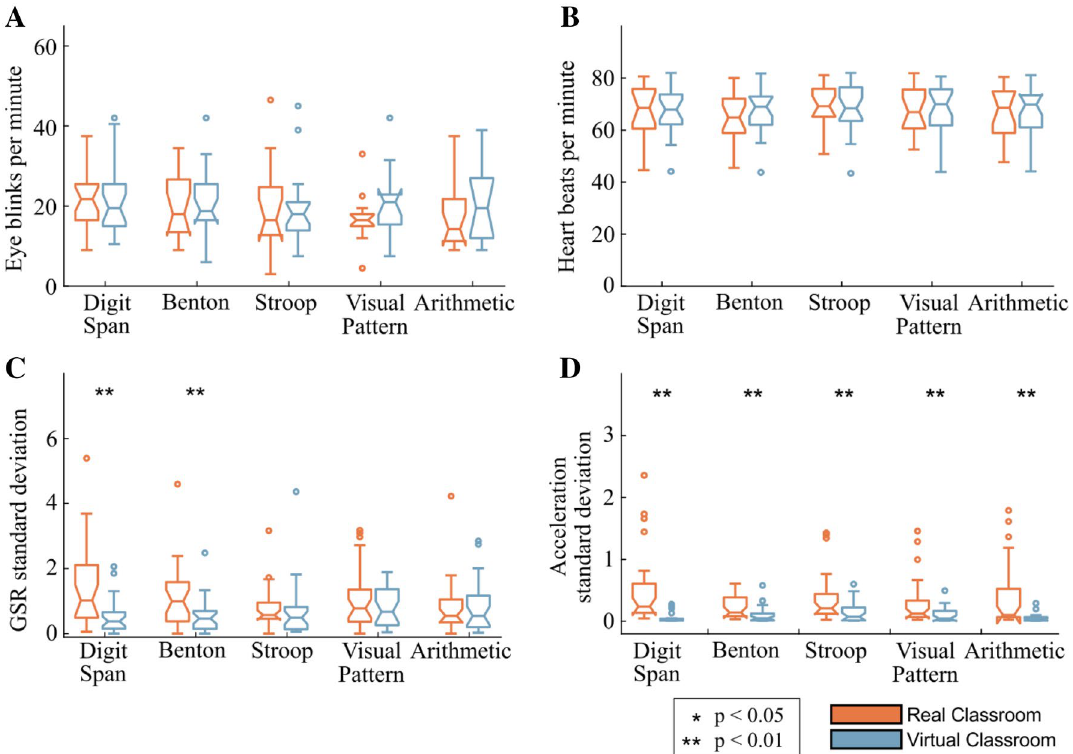
Figure 3. Physiological responses in the real-world classroom environment vs. identical virtual classroom. The color bars indicate the median scores in each environment, with the first and third quartiles shown as error bars. ( A ) Number of eye blinks per minute per cognitive test, as derived from the EOG sensors, ( B ) number of heart beats per minute, as derived from the ECG sensors, ( C ) relative standard deviation of tonic GSR data, and ( D ) relative standard deviation of the head acceleration